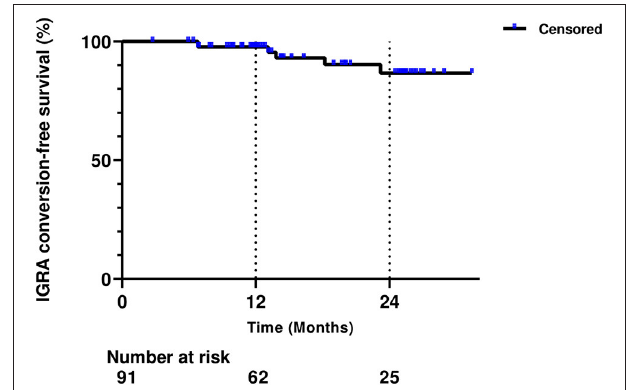
FIGURE 1 | Cumulative interferon-gamma release assay (IGRA) conversion-free survival rate after starting non-tumor necrosis factor inhibitor